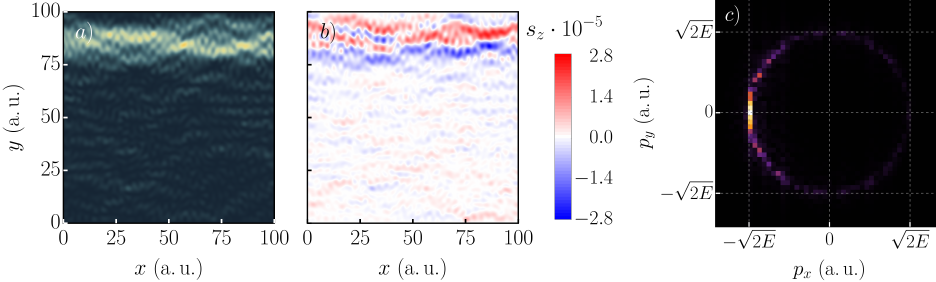
Figure 5. Probability density ( a ) of the 1821st state ( s z = − 1), spin-polarized density ( b ), and the Fourier-transformed spin density ( c ) for a square system of lengths 100a.u. with periodic boundary conditions in the x -direction, α = 20meVÅ, B = 1T with ten impurities with a strength of 0.18a.u. and FWHM = 8a.u. The energy is E = 0.59a.u. The momentum distribution indicates that the particle moves along the − x -direction. The path at y = 85a.u. consists of the spin-up (red) and spin-down (blue) channels, which are